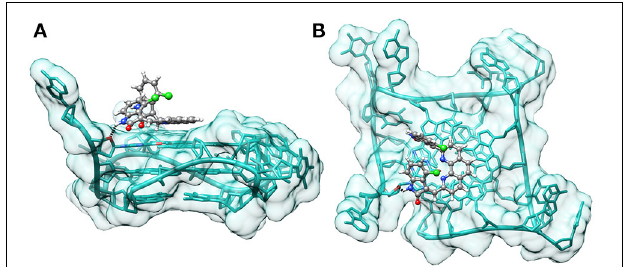
FIGURE 7 | Binding pose of 2b on tel23-p. Side (A) and top-view (B) of the binding pose of 2b on tel23-p obtained by docking calculations. Hydrogen bond between the indolinone moiety and the O4 (cid:2) atom of a deoxyribose ring is depicted with a dashed black line.